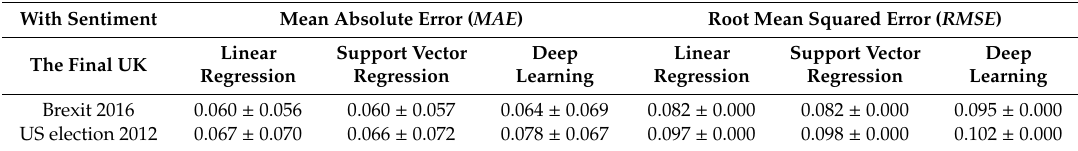
Table 8. Results for the UK with event sentiments.